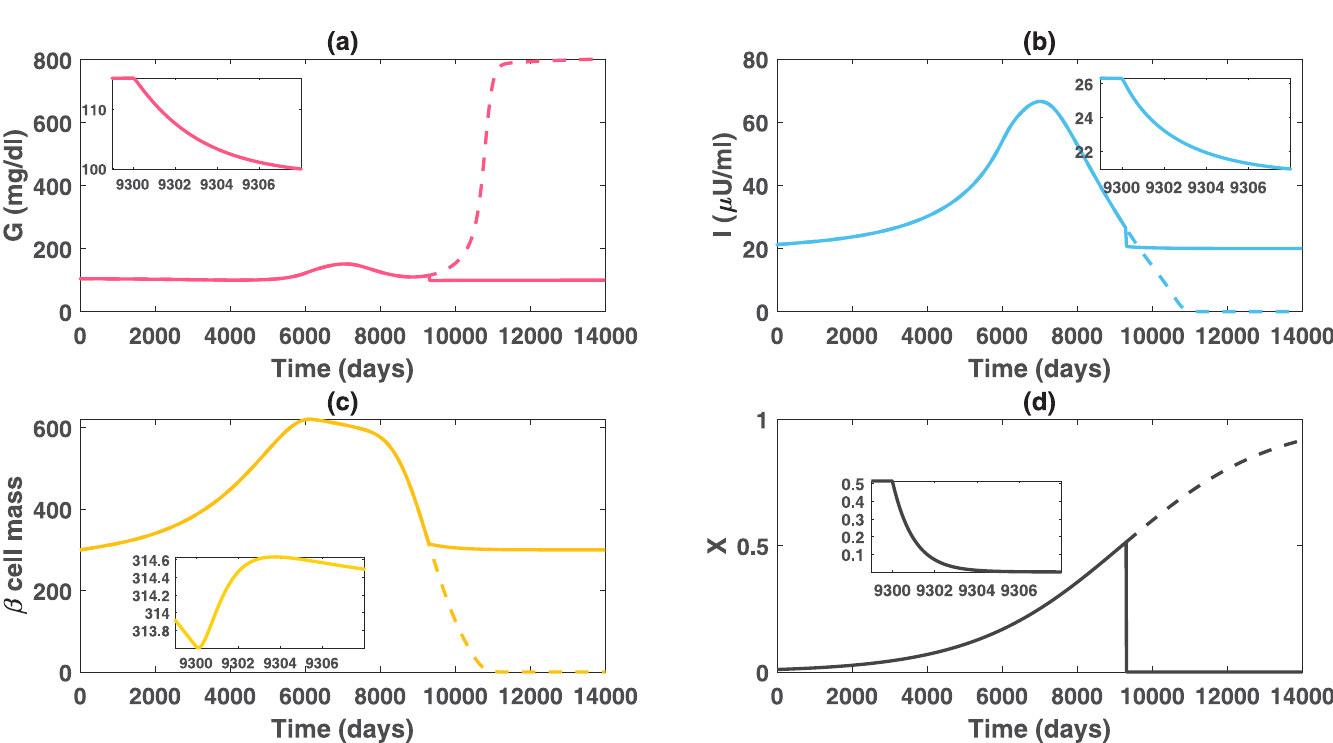
Fig 5. Altered dynamics of glucose, insulin and functional beta-cell mass level for patient A after taking the Roux-en-Y gastric bypass surgery. The patient is assumed to take the surgery on day 9300 and the obesity-related factor X is postulated to decrease exponentially to zero in approximately a week. The GI β dynamics with taking the Roux-en-Y surgery are plotted in solid curves and the dashed curves represent the expected GI β trajectories without taking the intervention. The solid curves are zoomed in to show the variations of the GI β levels during the week after surgery. All of the other parameters here remain the same as those in Fig 2, except for those in the equation of X . Graph (a) illustrates that in contrast to the upsurge of glucose level after day 9300 without any intervention, the glucose levels are reduced to 100 mg/dl following surgery for one week. Graph (b) and (c) demonstrate the bariatric surgery can promptly halt the occurrence of beta-cell failure and insulin deficiency. Normal levels of insulin can be maintained after the first